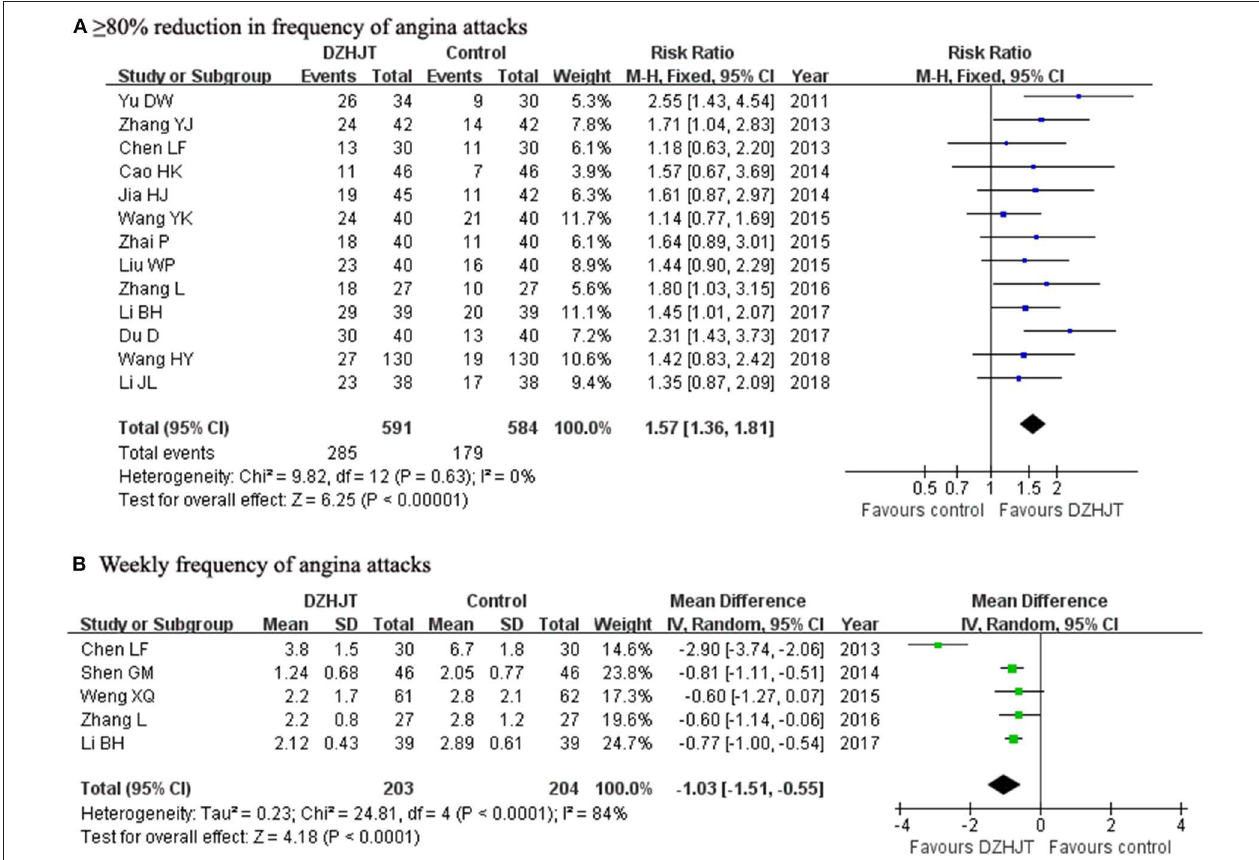
FIGURE 2 | Forest plots showing comparison of ≥ 80% reduction in frequency of angina attacks (A) and weekly frequency of angina attacks (B) in patients with or without DZHJT treatment.